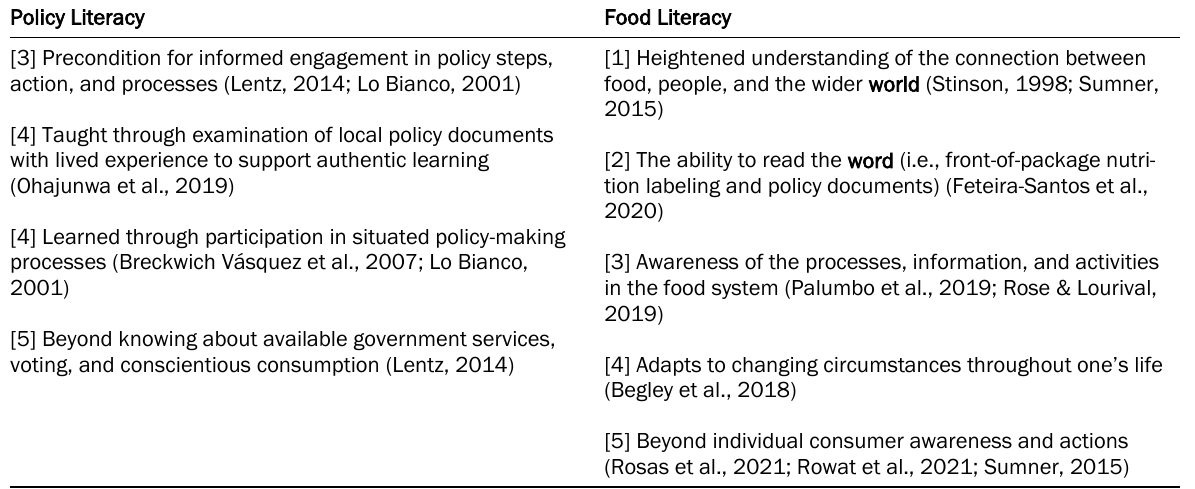
Table 1. Conceptualizing Critical Food Policy Literacy from the Family Resemblance Relationship of Policy Literacy and Food